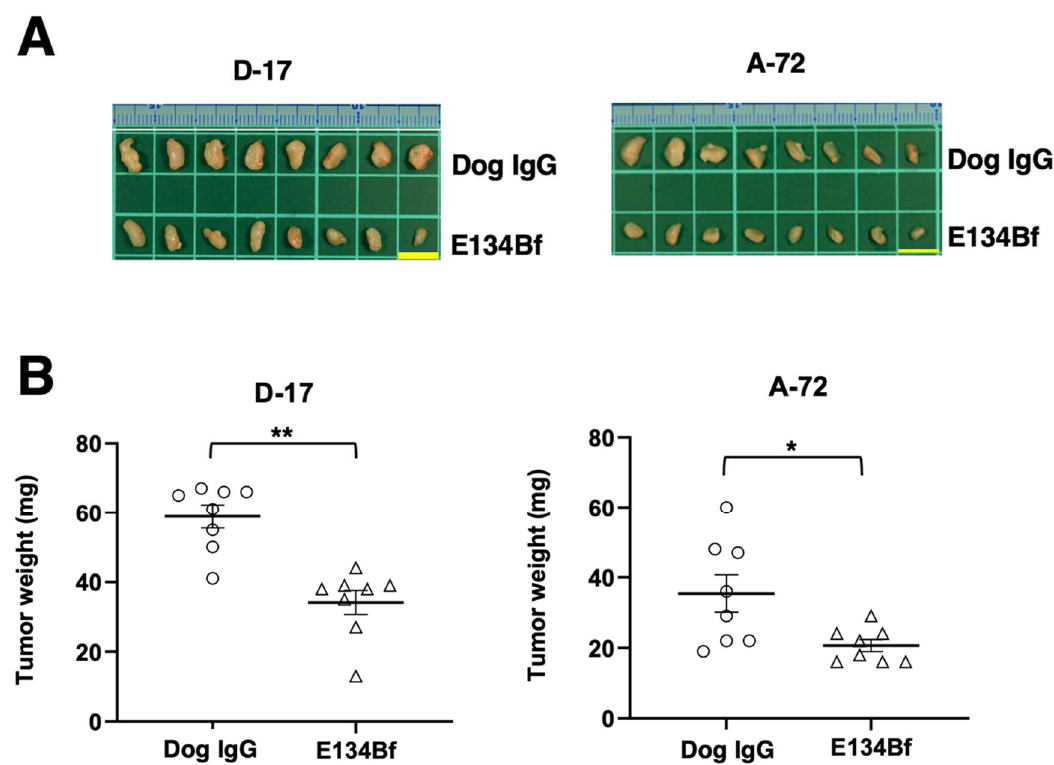
Figure 6. Evaluation of tumor weight in the D-17 and A-72 xenograft models. The tumors of the D-17 and A-72 xenografts were resected from the control dog IgG and E134Bf groups. ( A ) Appearance of resected tumors of the D-17 and A-72 xenografts from the control dog IgG and E134Bf groups on day 25. Scale bar, 1 cm. ( B ) The tumor weight on day 25 was measured from the excised D-17 and A-72 xenografts. The values are expressed as mean ± SEM. Asterisk indicates statistical significance (** p < 0.01, * p < 0.05, Welch’s t- test).